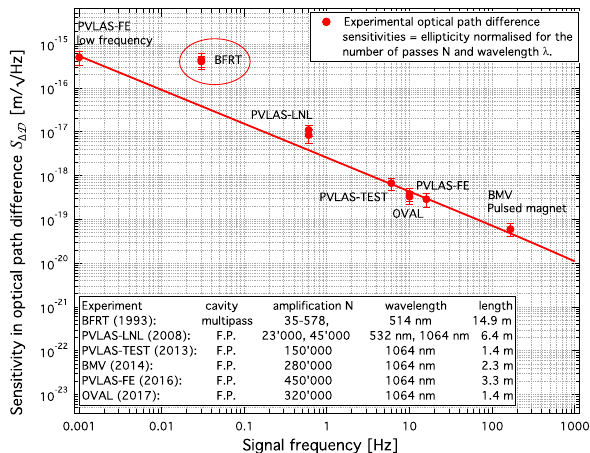
Fig. 3 Measuredopticalpathdifferencesensitivityforpastandpresent experiments as a function of their typical working frequency. BFRT [28], PVLAS-LNL [25,29], PVLAS-TEST [30], BMV [21], PVLAS- FE [19], OVAL [22]. The line is a fit with a power law having excluded the BFRT values. The resulting power is ( − 0 . 78 ± 0 . 03 )